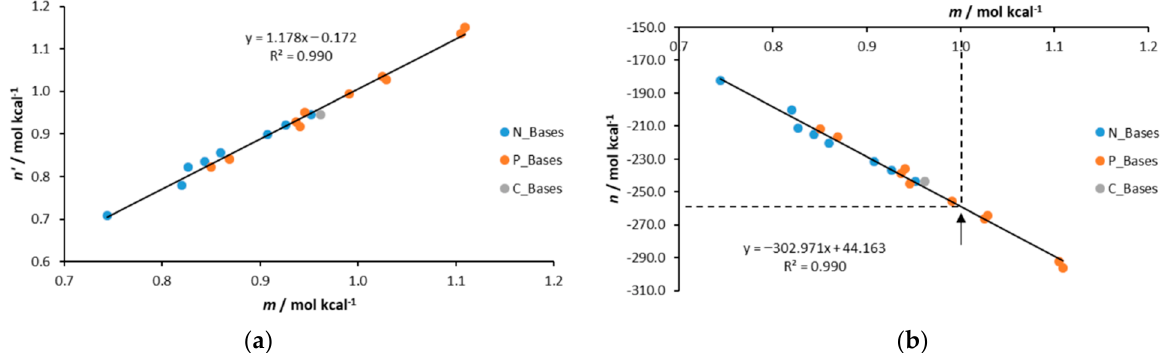
Figure 4. Linear dependence of parameters ( a ) n’ against m and ( b ) n against m . (for the meaning of m , m , n , and n’ , see Equations (4) and (5)). The arrow shows the interpolated point from which G° s,opt (H + ) was calculated.